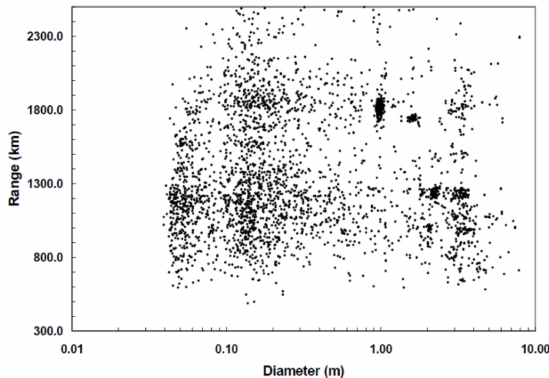
Figure 12. Results from Cobra Dane collected during the IADC 24 h campaign conducted in Septem- ber 2004 [25]. Reprinted from Proceedings of the 4th European Conference on Space Debris, Copyright 2005, with permission from